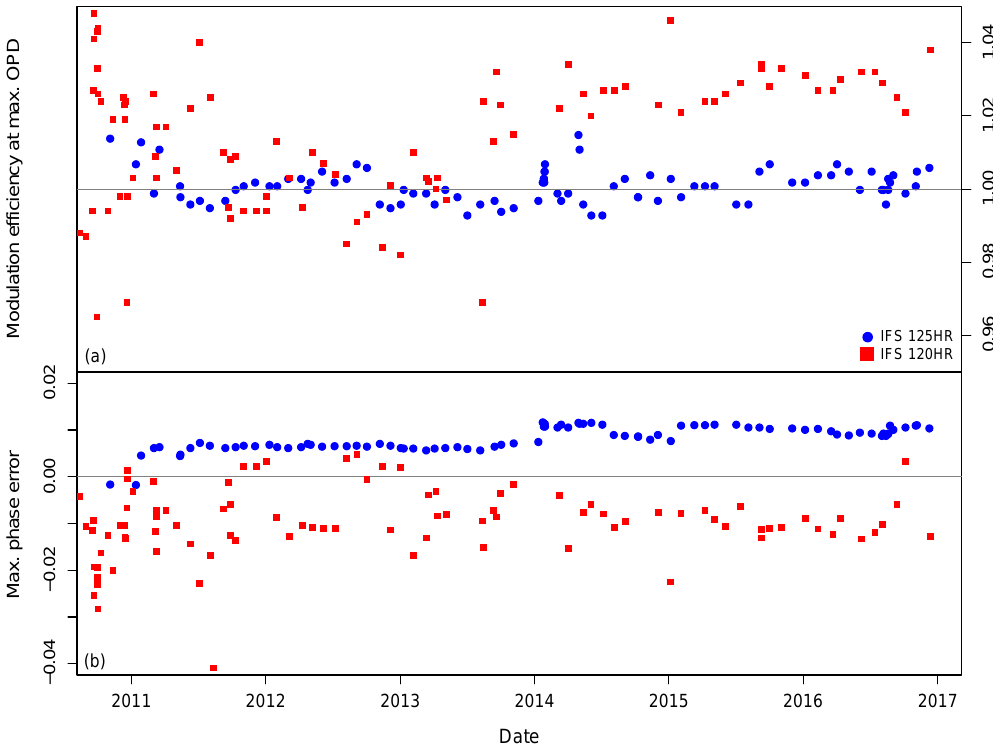
Figure 2. The time series of retrieved modulation efficiencies at 45cm optical path difference (a) and maximum phase error (b) for the Bruker IFS120HR and IFS125HR instruments at Lauder, based on lamp measurements of a 10cm HCl cell, indicating the improved stability of the IFS125HR instrument line shape over